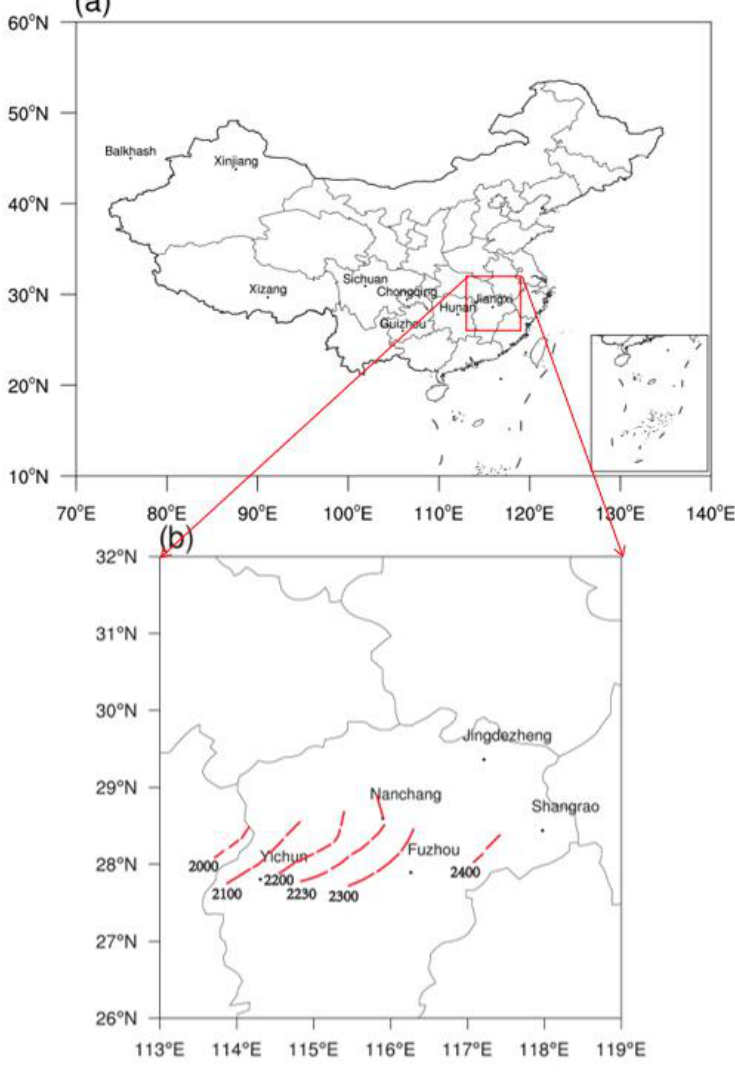
Figure 1. ( a ) Locations of some provinces in China which are discussed in this paper (Jiangxi, Hunan, Xinjiang, Sichuan, Chongqing, Guizhou, Xizang), the red box is the area of b; ( b ) Locations of five radars (Nanchang, Yichun, Jingdezheng, Shangrao, and Fuzhou) used in this study. (Red dashed line represents the path of the squall line obtained from the radar composite reflectivity from 2000 UTC to 2400 UTC on 15 April